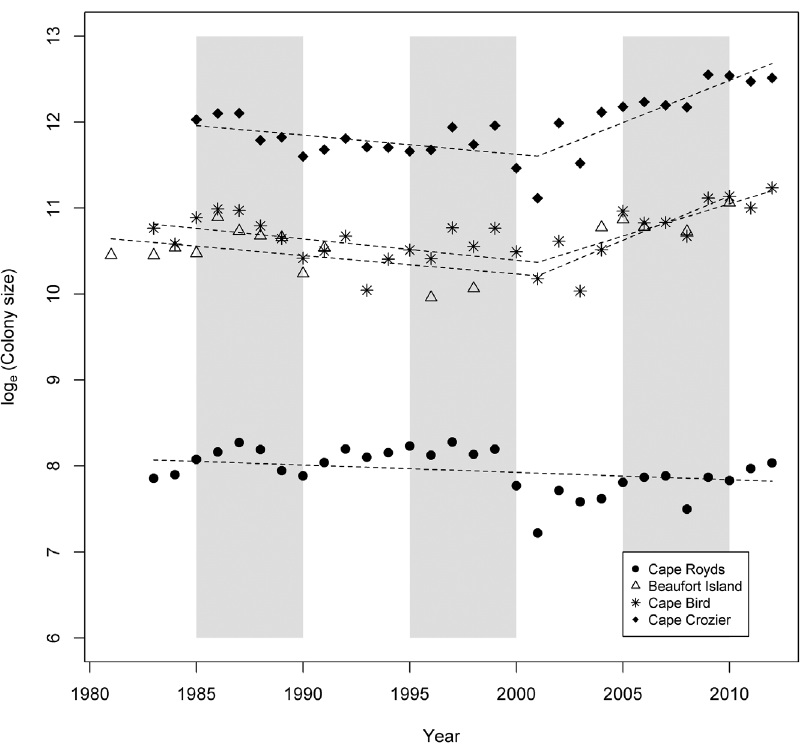
Figure 2. Time-series plots of the logged Ade´lie penguin colony counts at Cape Royds, Cape Bird, Cape Crozier and Beaufort Island, Antarctica from 1981 to 2012. The linear regression trend lines are for the period 1981–2000.